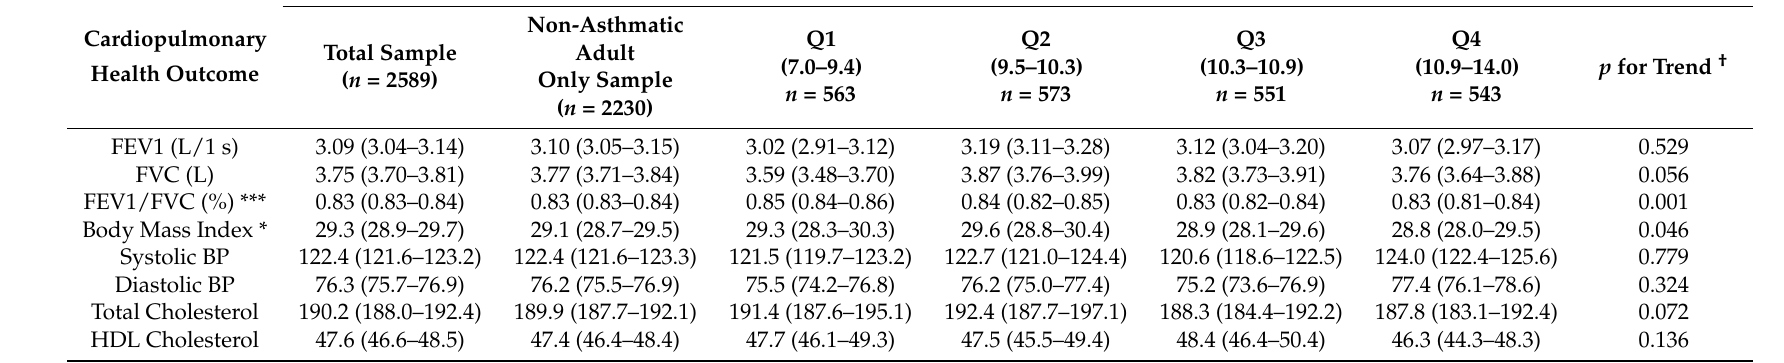
Table 2. Descriptive Trends in Cardiopulmonary Health Outcomes among 2008–2013 SHOW adults (age 21–74), overall, in non-asthma only sample and by quartile of 3-year annual average exposure to PM 2.5 .